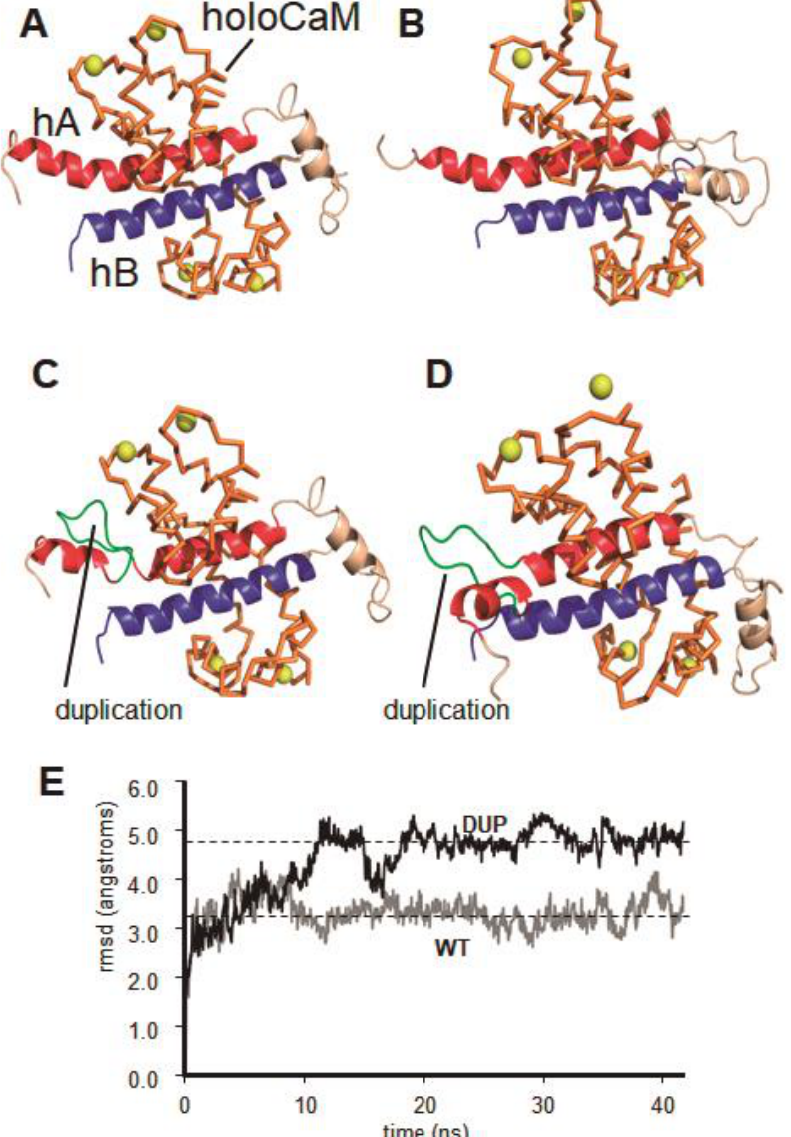
Figure 3. Analysis of unrestricted molecular dynamics simulation of the wild-type and variant calmodulin domain of the KCNQ2 proteins. ( A ) Structural model of the CaM binding domain of WT-KCNQ2 (helices hA in red, and hB in blue) in the presence of CaM in the calcium-saturated state (holoCaM, orange). Calcium ions are depicted as yellow spheres. ( B ) Same structure as in ( A ) after 40 ns of unrestricted molecular dynamics simulation. ( C ) Structural model of the CaM binding domain of the variant DUP-KCNQ2, containing the duplicated sequence (VQEQHRQKHFEK sequence, residues 320–331, green loop). ( D ) Same structure as in ( C ) after 40 ns of unrestricted molecular dynamics simulation. ( E ) Root mean square deviation (rmsd) values measured over the 40 ns molecular dynamics trajectories of the wild-type (WT-KCNQ2) and the variant (DUP-KCNQ2) structures. Note the higher variation of the rmsd values in the case of the DUP-KCNQ2 structure, caused by the presence of the duplicated sequence, while the WT-KCNQ2 structure does not change significantly.